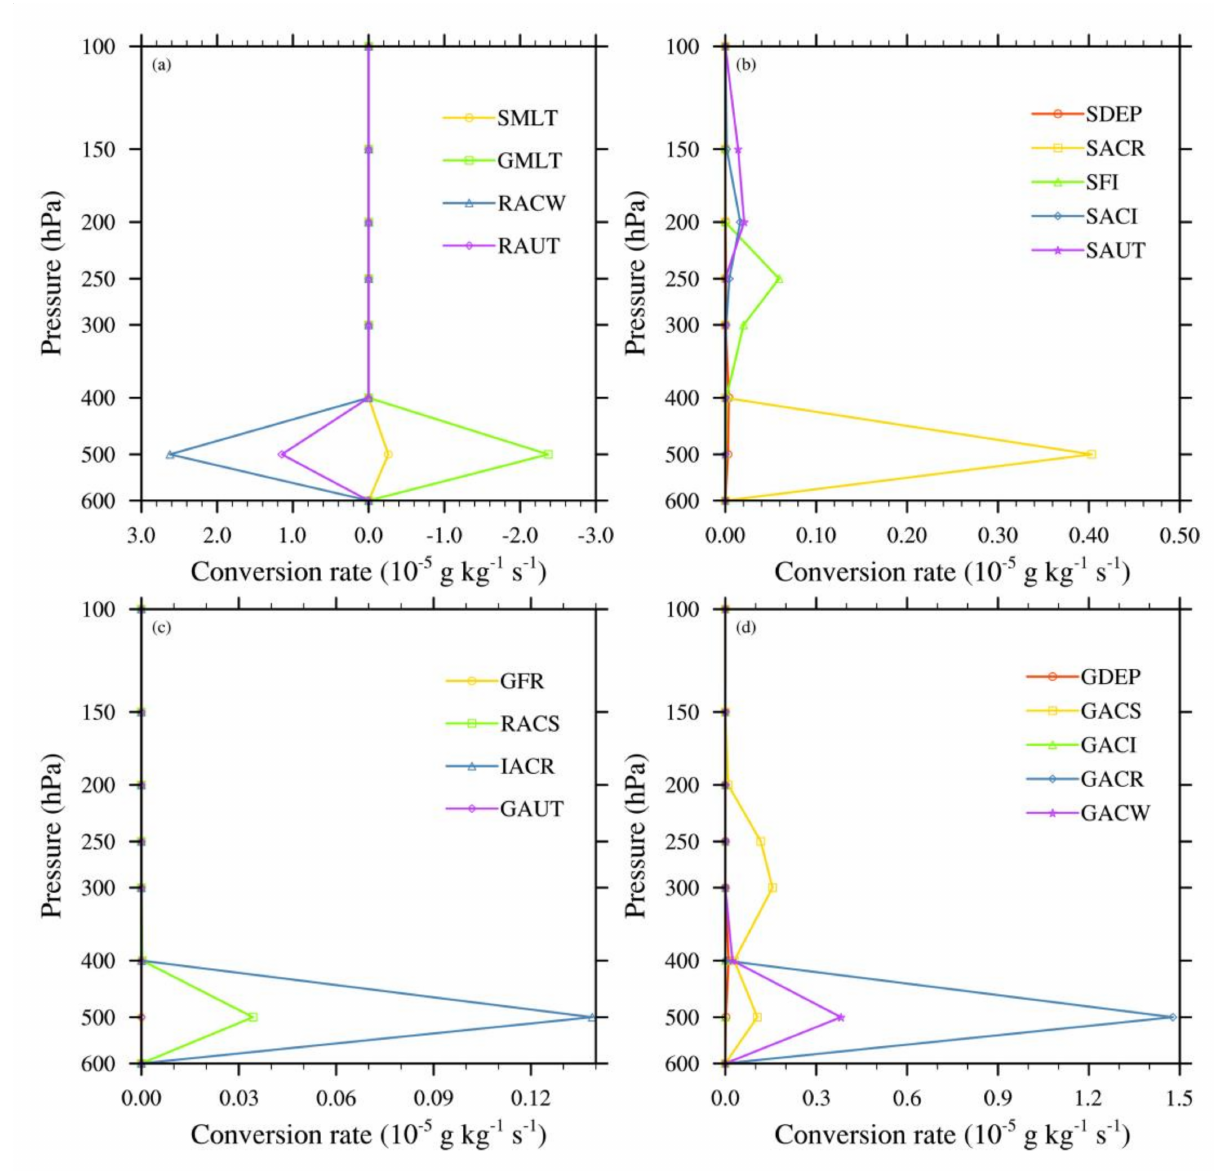
Figure 7. Conversion rate of the water source item to a horizontally averaged figure: ( a ) rainwater source item, ( b ) snow source item, ( c ) graupel primary source item, ( d ) graupel growth source item. This figure is obtained by the regional averaging of the black dashed area (32.5–33.5 ◦ E, 96.5–97.5 ◦ N) in Figure